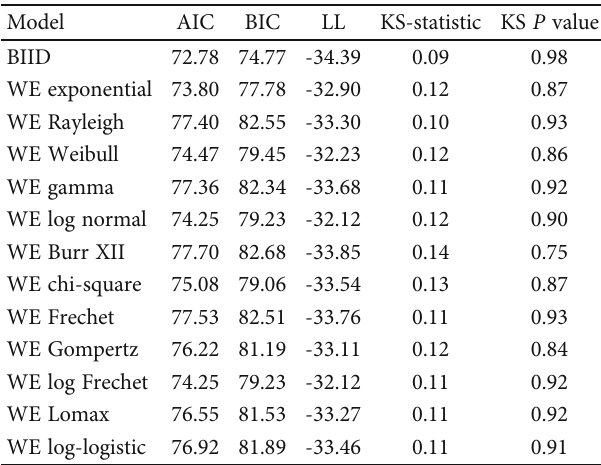
Table 14: Comparison of BIID with class of WEGDs using real